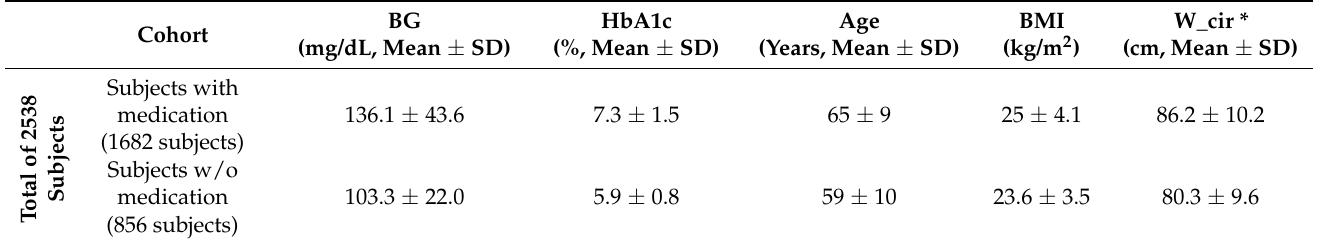
Table 2. Characteristics of the participants of cohorts with and without medications.